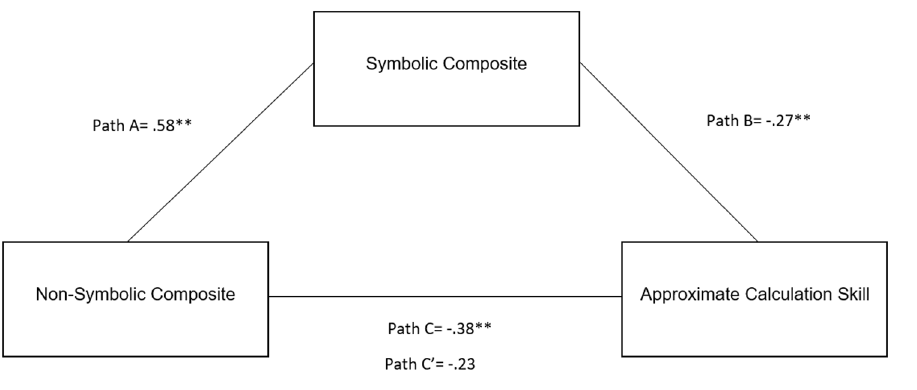
Figure 3. Mediation model of approximate calculation skill, non-symbolic system performance and symbolic system performance. Beta values